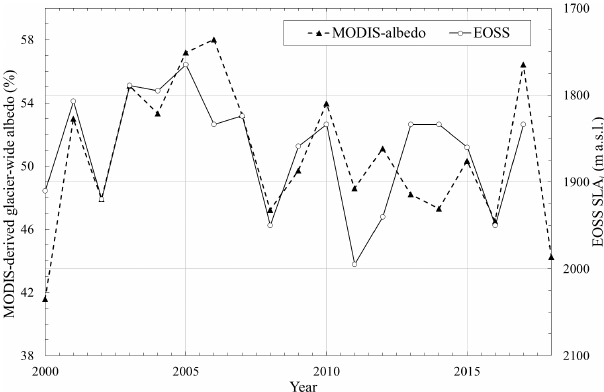
Figure 11. Comparison of MODIS-derived ¯ α min yr and EOSS SLA i on Vertebrae Col 25 between 2000 and 2018 ( R 2 = 0 .